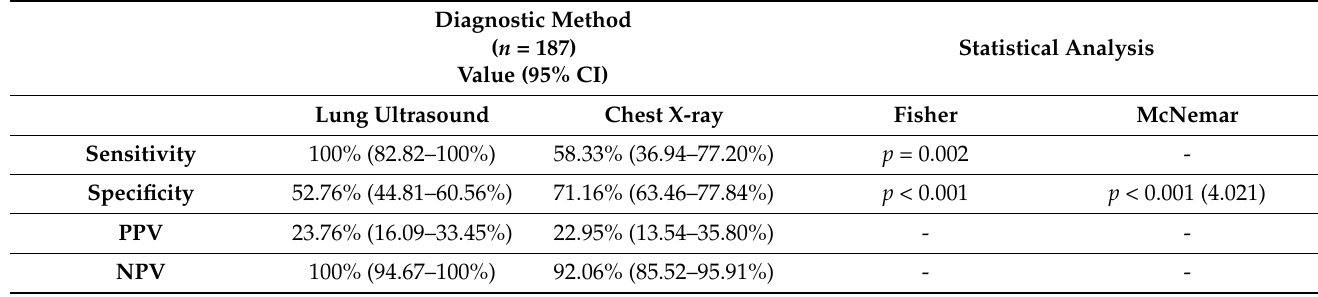
Table 5. Comparative study of lung ultrasound and chest X-ray in early detection of COVID-19-related severe intersti- tial